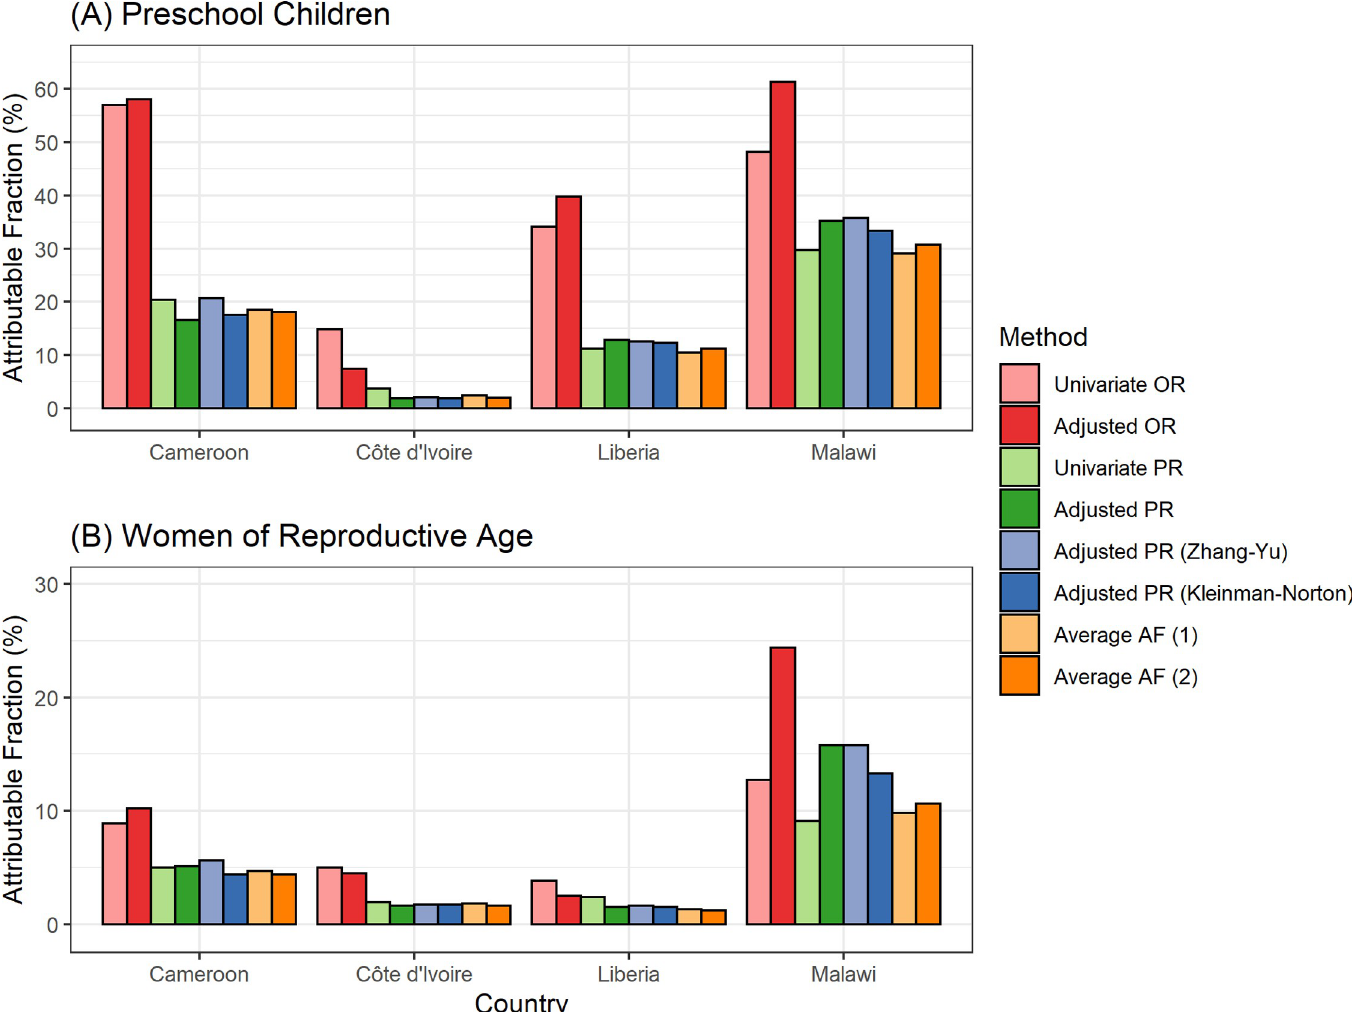
Fig 3. Estimated attributable fractions of anemia associated with malaria in (A) preschool children and (B) women of reproductive age. Anemia defined as hemoglobin adjusted for altitude < 11.0 g/dL for children and hemoglobin adjusted for altitude and smoking < 12.0 g/dL for women. Average AF (attributable fractions) (1) considers all exposure variables including malaria, blood disorder, and micronutrient deficiencies depending on data availability. Average AF (2) considers all exposure variables and adjusts for age, sex (for children), and SES. Covariates for adjusted OR and adjusted PR included all available exposure variables, age, sex (for children), and